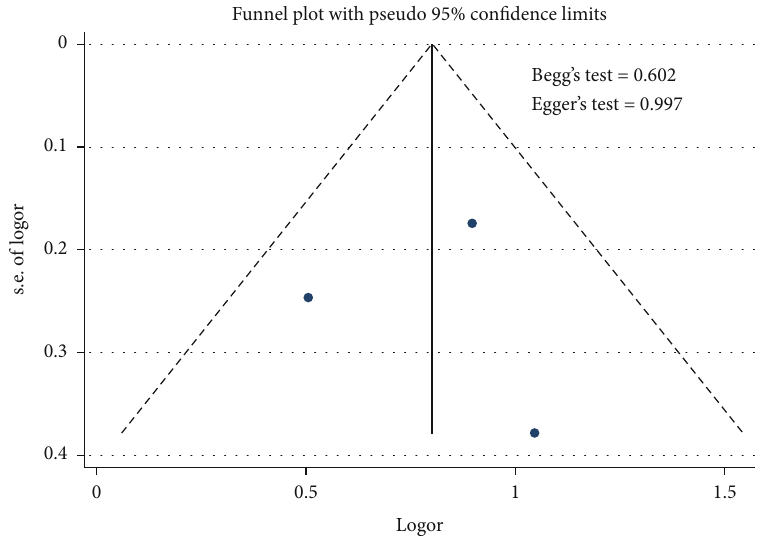
Figure 3: Funnel plot role of medication nonadherence on the uncontrolled hypertension.